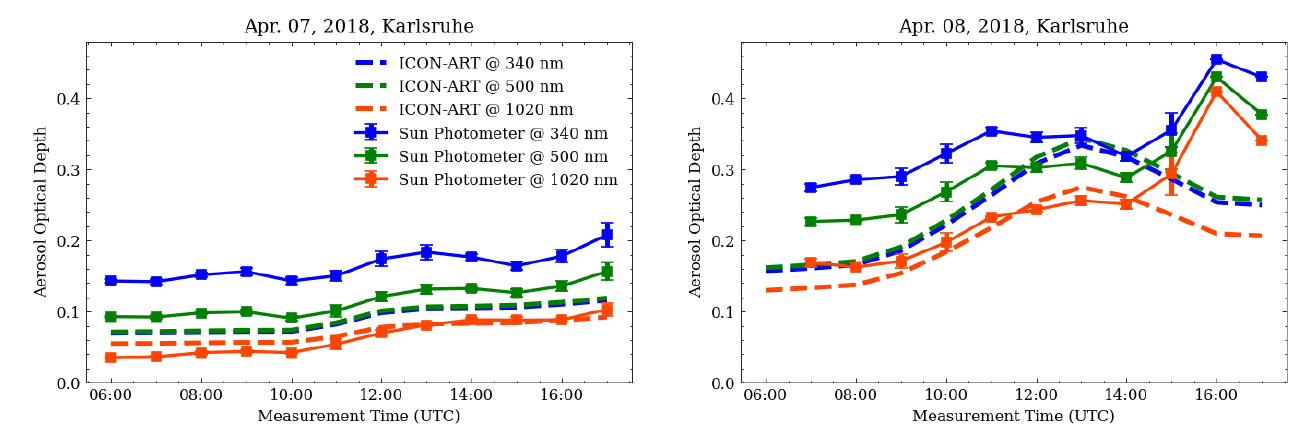
Figure 10. AOD from the sun photometer and ICON-ART model simulation on 7 and 8 April for a 1 h temporal